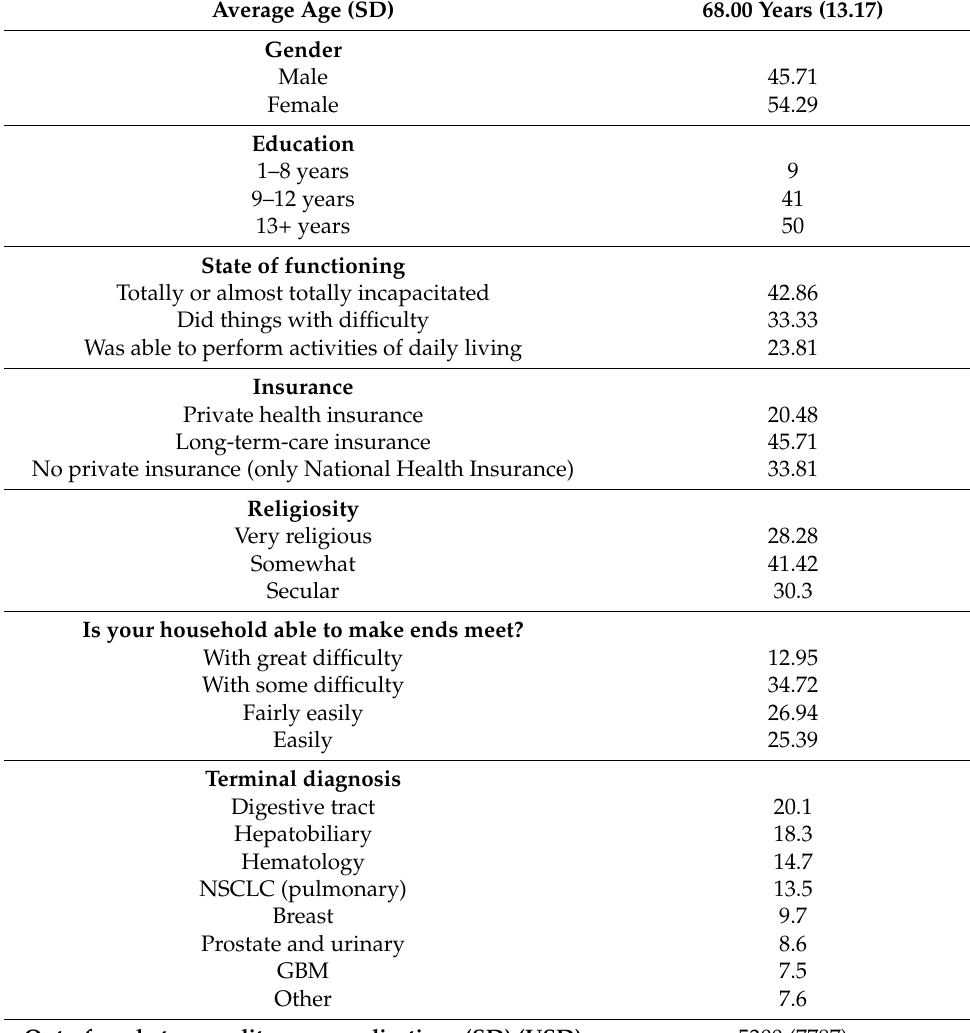
Table 1. Characteristics of deceased cancer patients